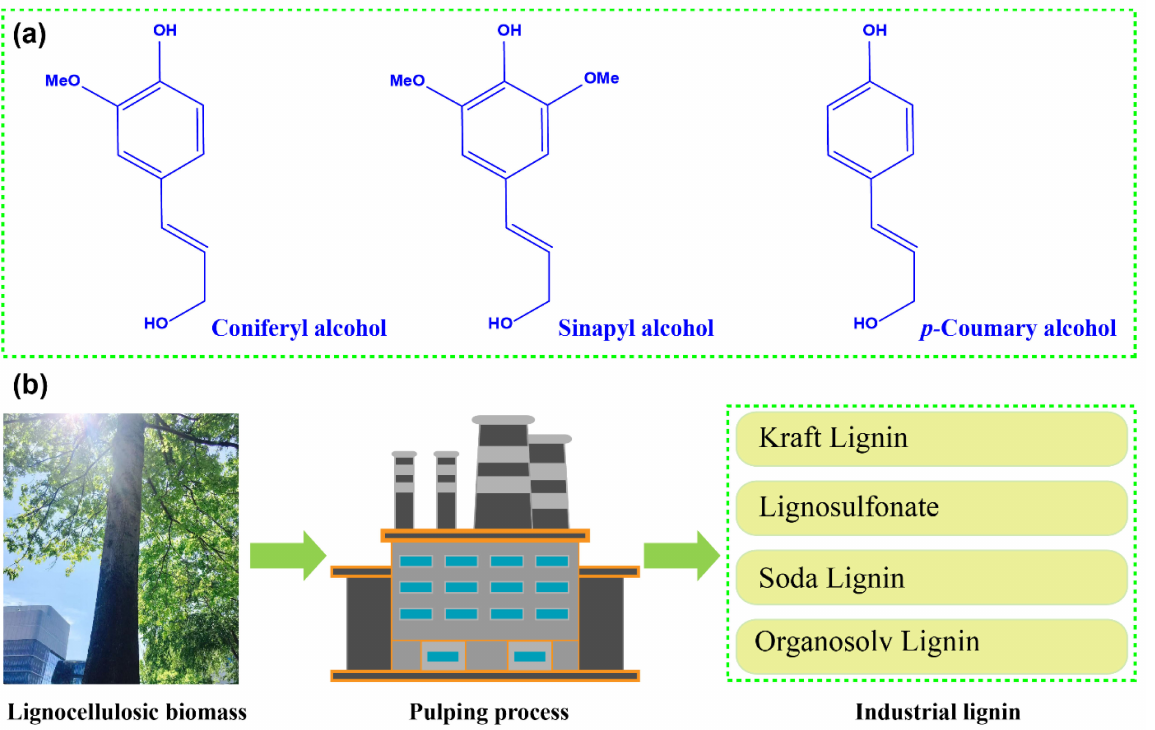
Figure 2. ( a ) Three monomers of industrial lignin. ( b ) Different pulping processes for the preparation of lignin derived from lignocellulosic